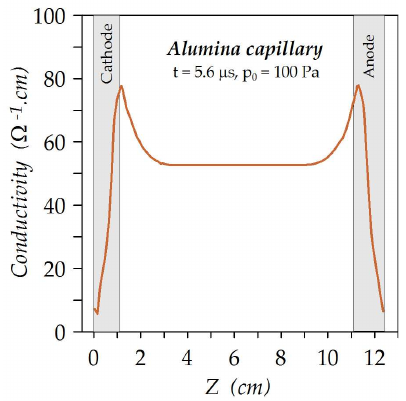
Figure 8. Plasma column conductivity Σ ( z ) at time 5.6 µ s.